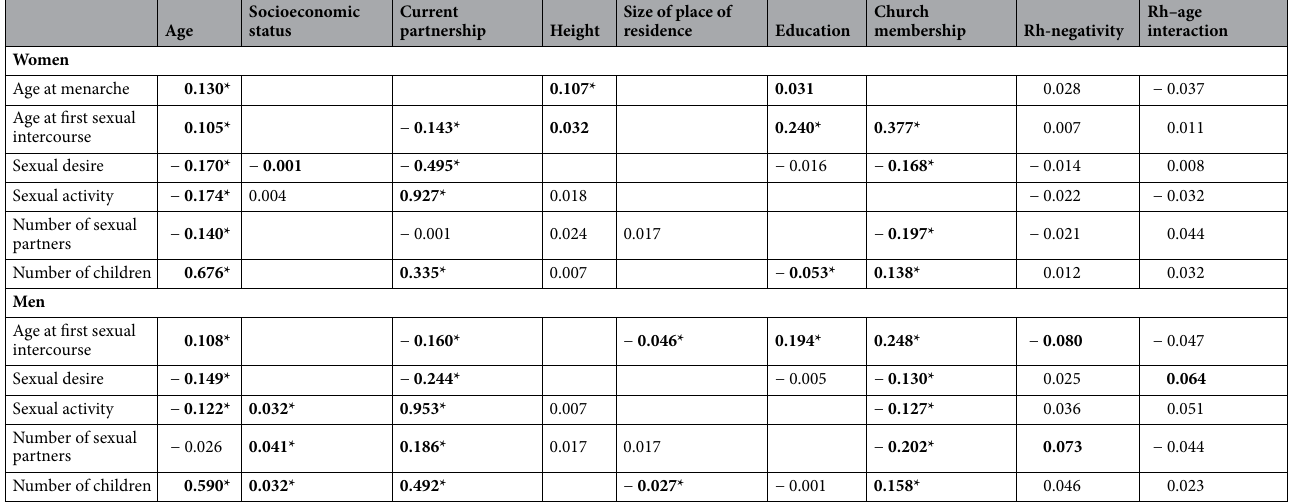
Table 3. Associations of Rh-negativity and covariates with each variable related to sexual life and reproduction. This table shows the results (standardised beta coefficients) of eleven univariate GLM analyses (Type III sums of squares) analysing associations between variables related to sexual life and reproduction (first column) and Rh-negativity and covariates. In accordance with the preregistration, each model includes only covariates with Kendall’s Tau > 0.02 or < − 0.02 for correlation with output variables (see Supplementary Table S3). Current partnership, church membership, and Rh-negativity were binary variables with 0 indicating no current partnership, no church membership, and a positive Rh phenotype, and 1 indicating being in a partnership, church membership, and a negative Rh phenotype. Associations with p values under 0.05 are in bold and those with p values under 0.005 are marked with